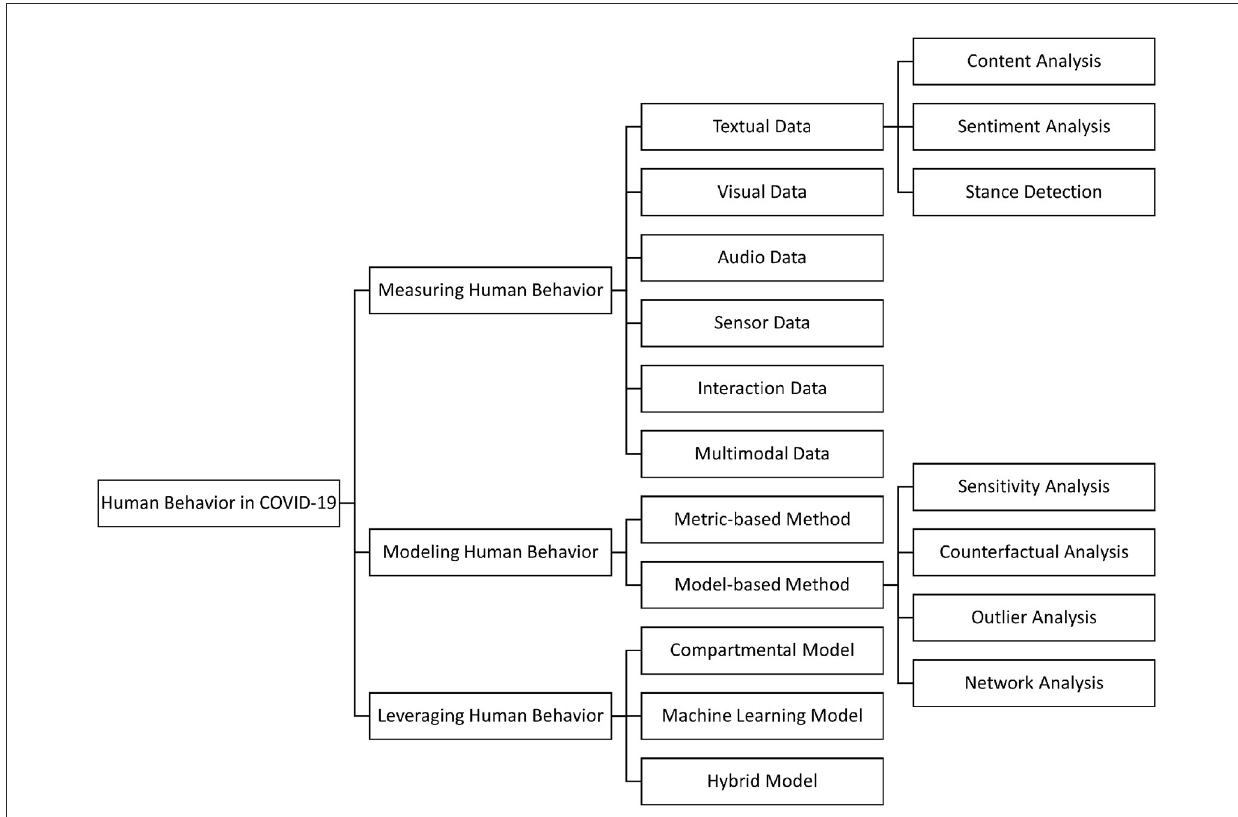
FIGURE1 The overall categorization of the reviewed